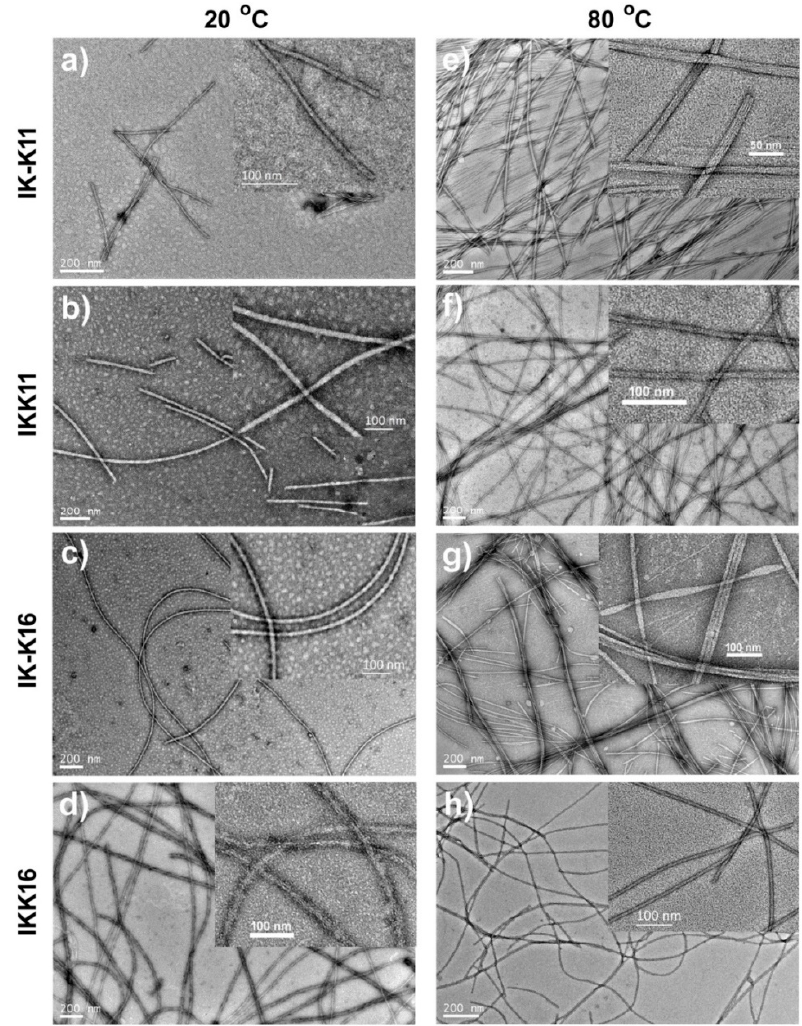
Figure 2. TEM morphologies show the self-assembled structures of different peptides at concentration of 4.0 mM and temperature of either 20 °C or 80 °C. Table 2. List of the CACs, the self-assembled structures and the corresponding size parameters of all peptides.